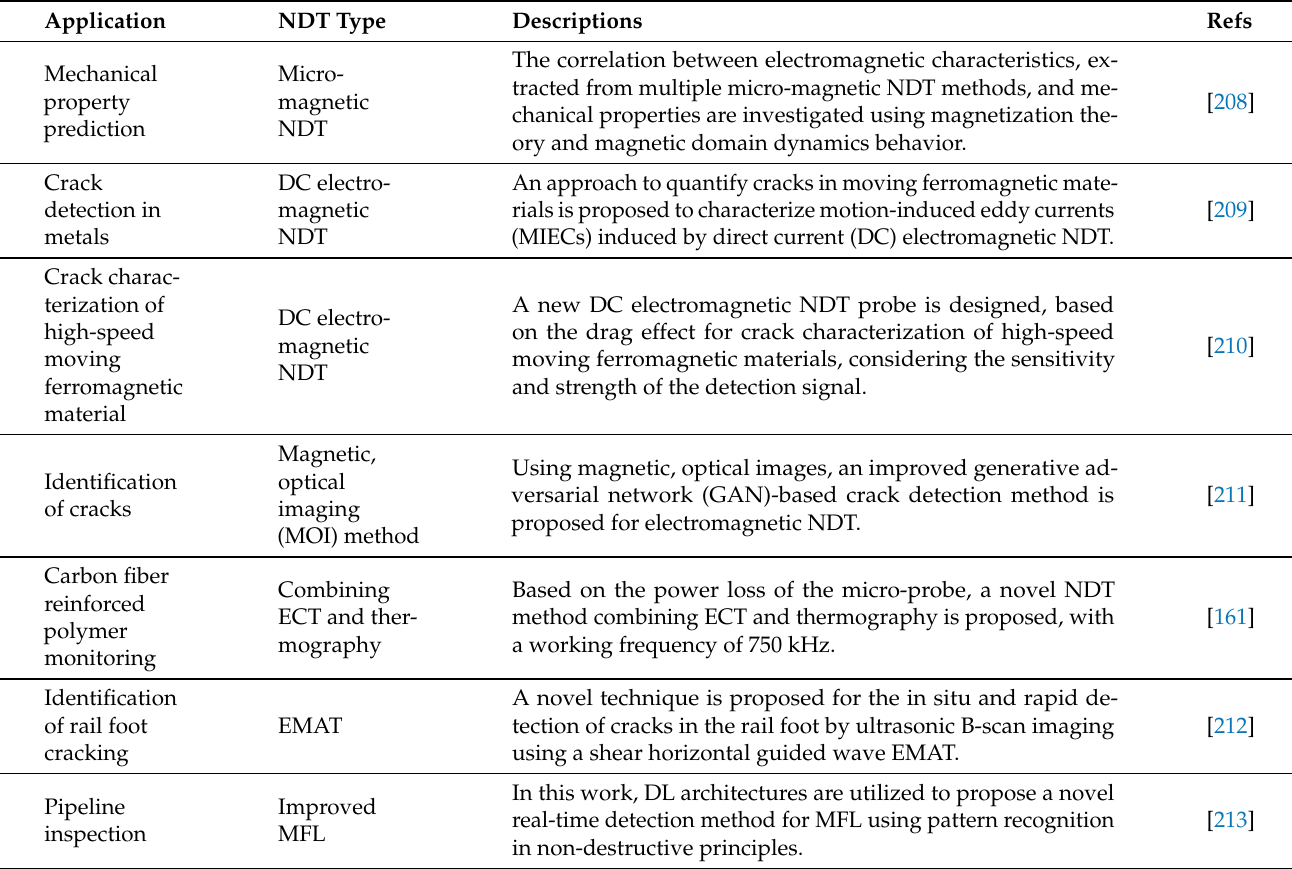
Table 11. Recent papers on advanced electromagnetic and magnetic